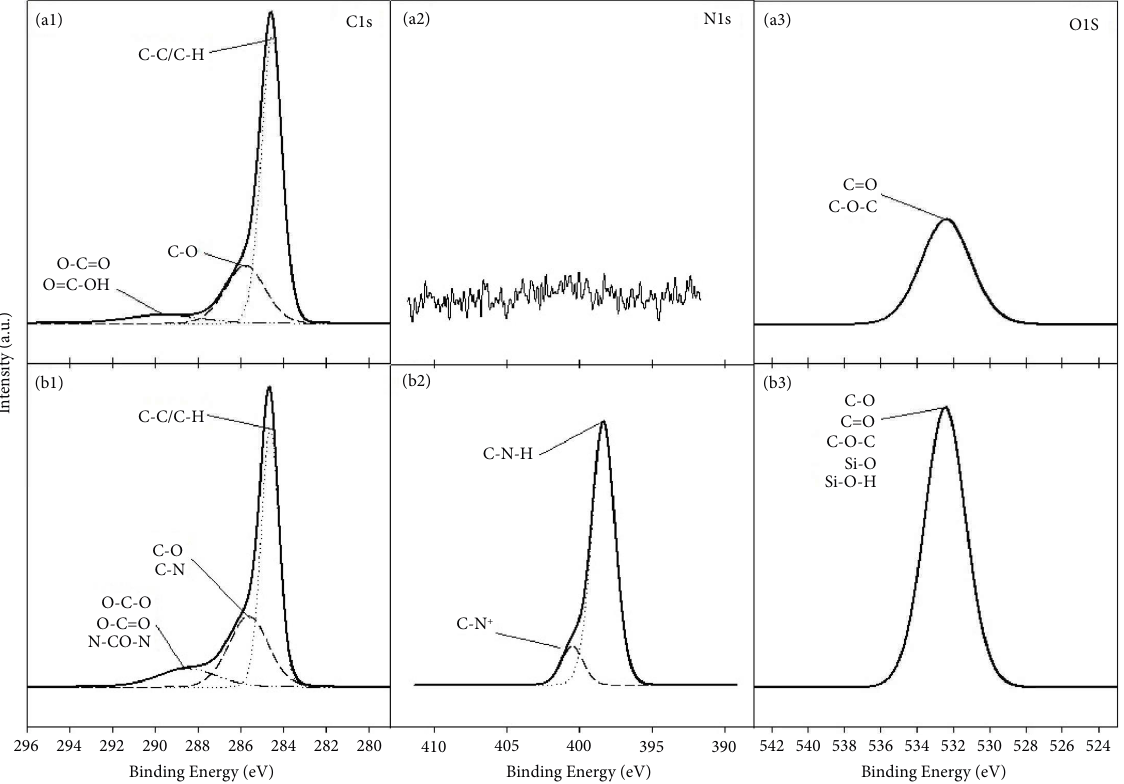
Figure 4: Representative peak-ftting XPS of the (1) C1s, (2) N1s, and (3) O1s signals of the (a) untreated AC and (b) APTES performed under a high vacuum condition ( ≤ 5 × 10 7 torr), calibrated by reference to the C1s peak at 284.6eV).